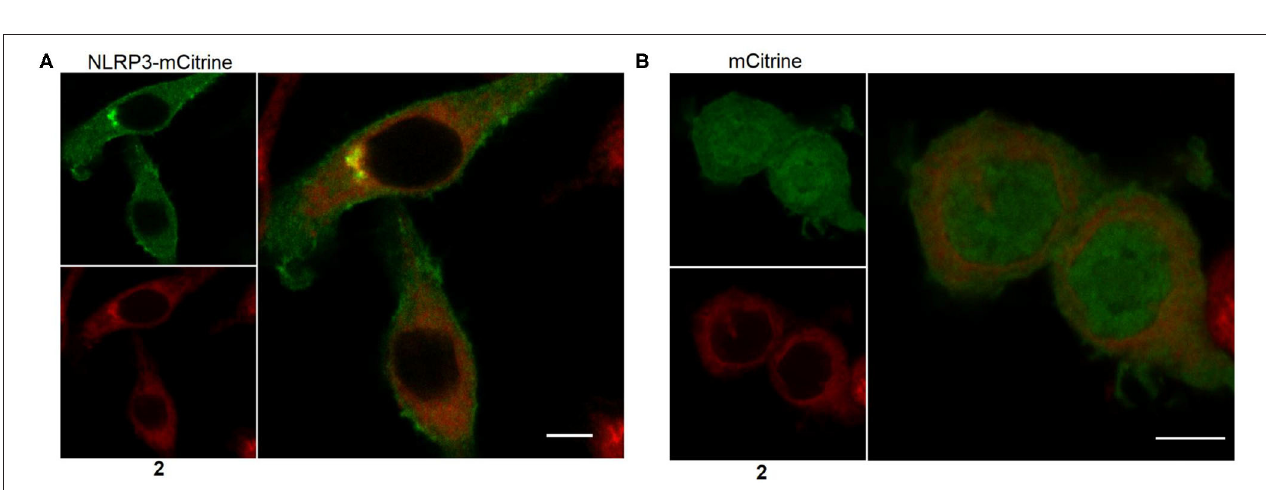
FIGURE 5 | Inhibition of IL-1 β release (A) in immortalized murine bone marrow-derived macrophages after treatment with CRID3/MCC950 and fluorescent probes 1 and 2 . LDH release (B) of immortalized murine bone marrow-derived macrophages after treatment with CRID3/MCC950 and fluorescent probes 1 and 2 . All data are means ± SEM ( n = 3), Student’s t -test. * P ≤ 0.05, ** P ≤ 0.01, *** P ≤ 0.001.